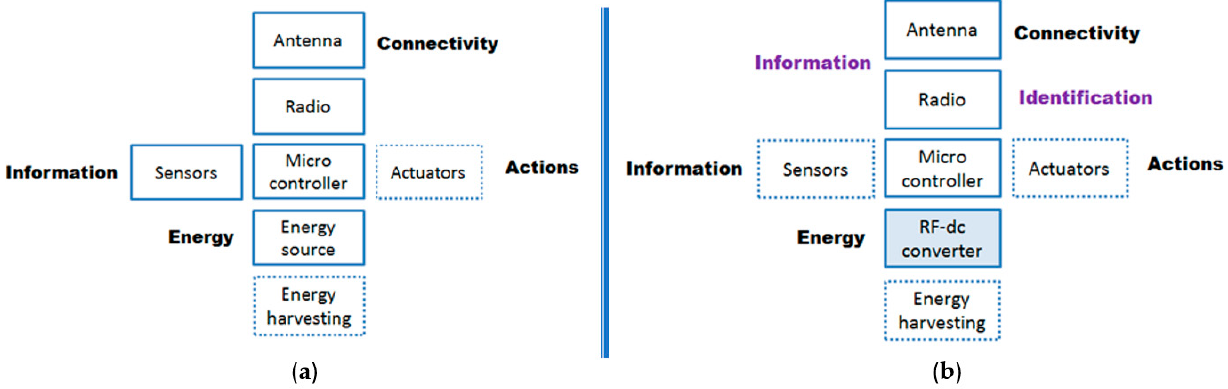
Figure 4. Comparison between architectures: ( a ) Low power sensor technology. ( b ) Passive UHF RFID sensor technology.